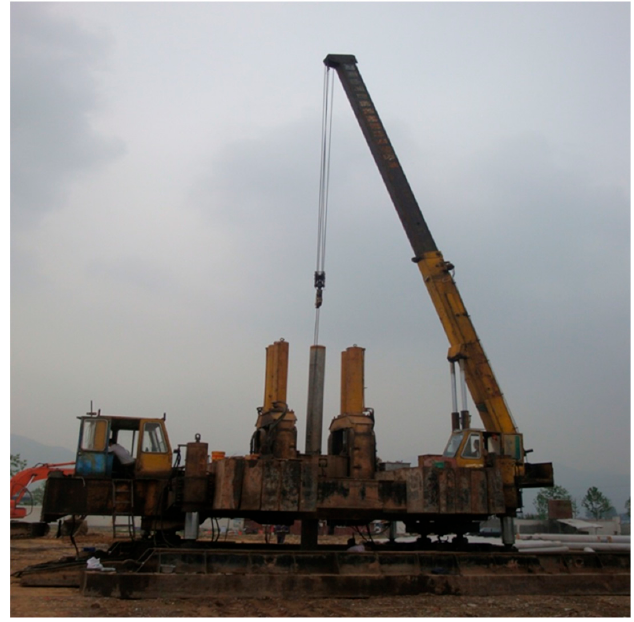
Figure 4. Jacking machine used in the test.